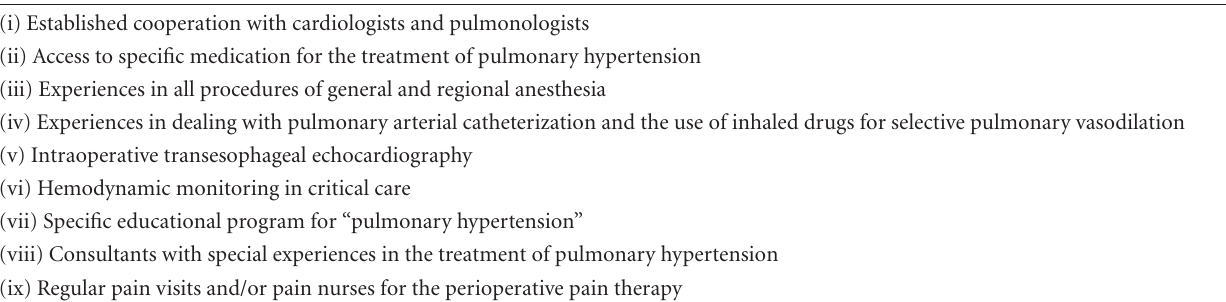
Table 9: Authors recommendations for the human and structural and technical requirements for the perioperative management of patients with severe pulmonary